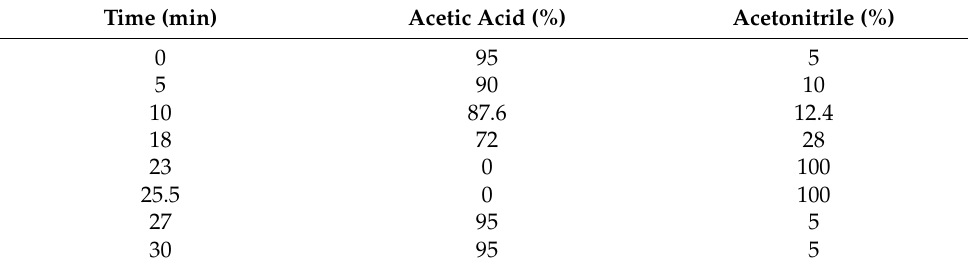
Table 1. Elution gradients for identifying phenolic compounds by